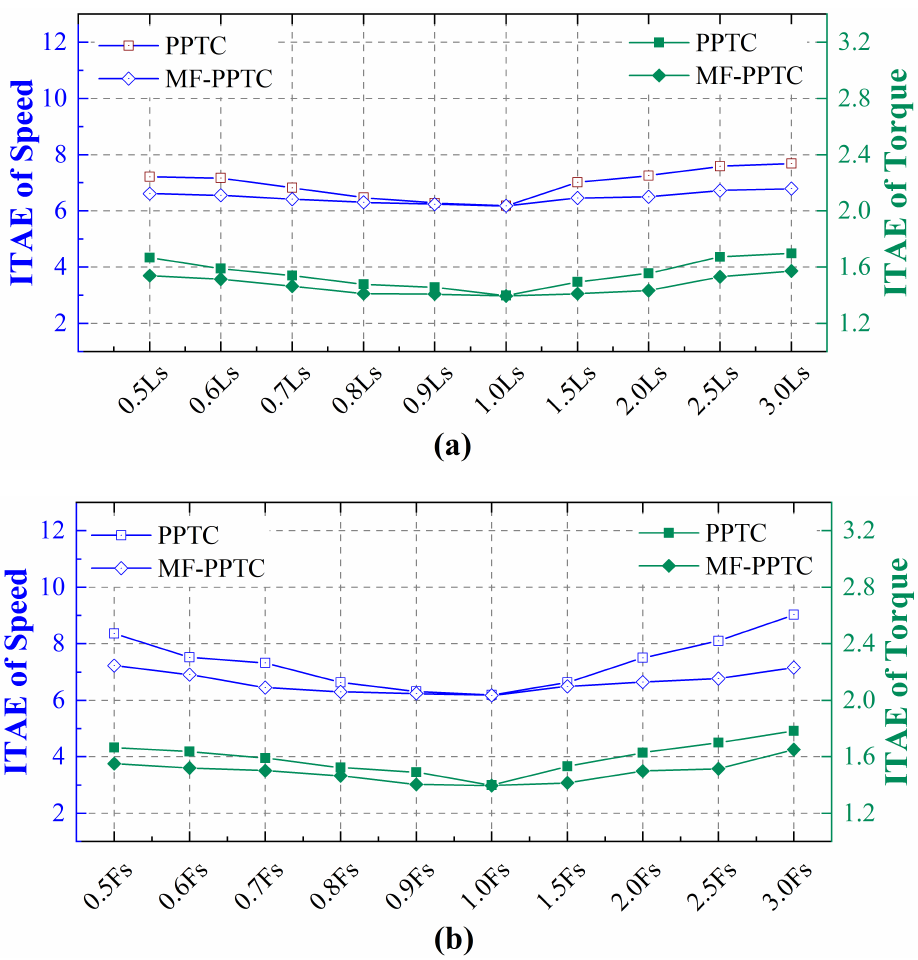
Figure 6. The simulation results of speed and torque ITAE values with mismatched parameters. ( a ) Variation of inductance. ( b ) Variation of